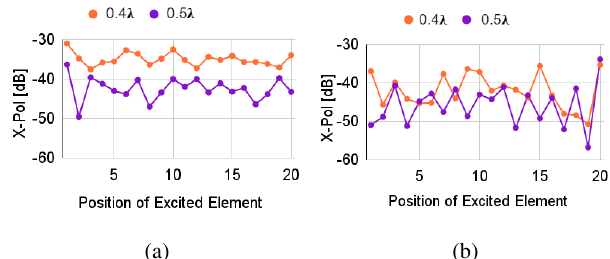
FIGURE 14: Cross-polarization level of active element pat- terns at different positions in the array for (a) H and (b) V polarizations better cross-pol level for elements spacing of 0.5 λ than 0 . 4 λ .